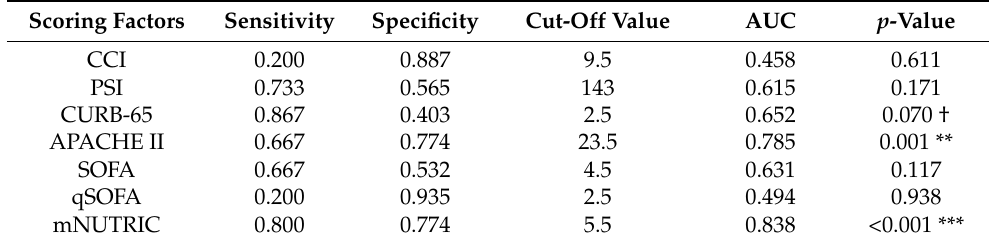
Figure 2. ROC curve analysis for predictability of mortality between different clinical prediction rules. Table 3. Comparison of the cut-off value, sensitivity, specificity, AUC, and p -value between severity scoring factors for hospital